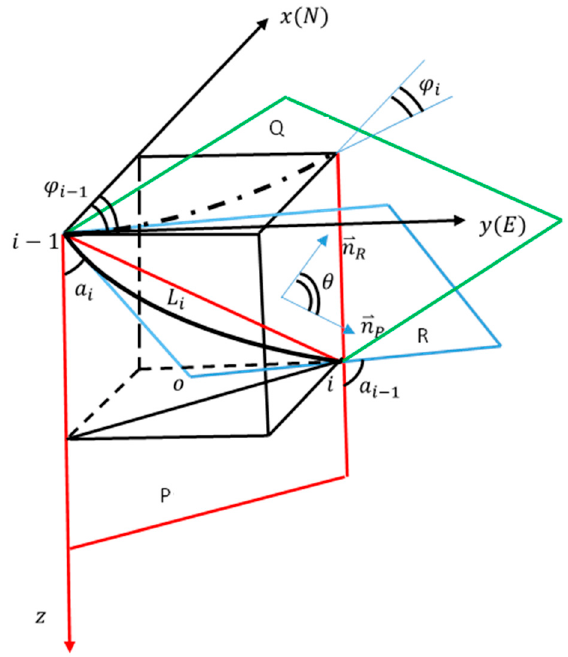
Figure 1. Relationship among R, P, Q planes of a 3D curved well section.